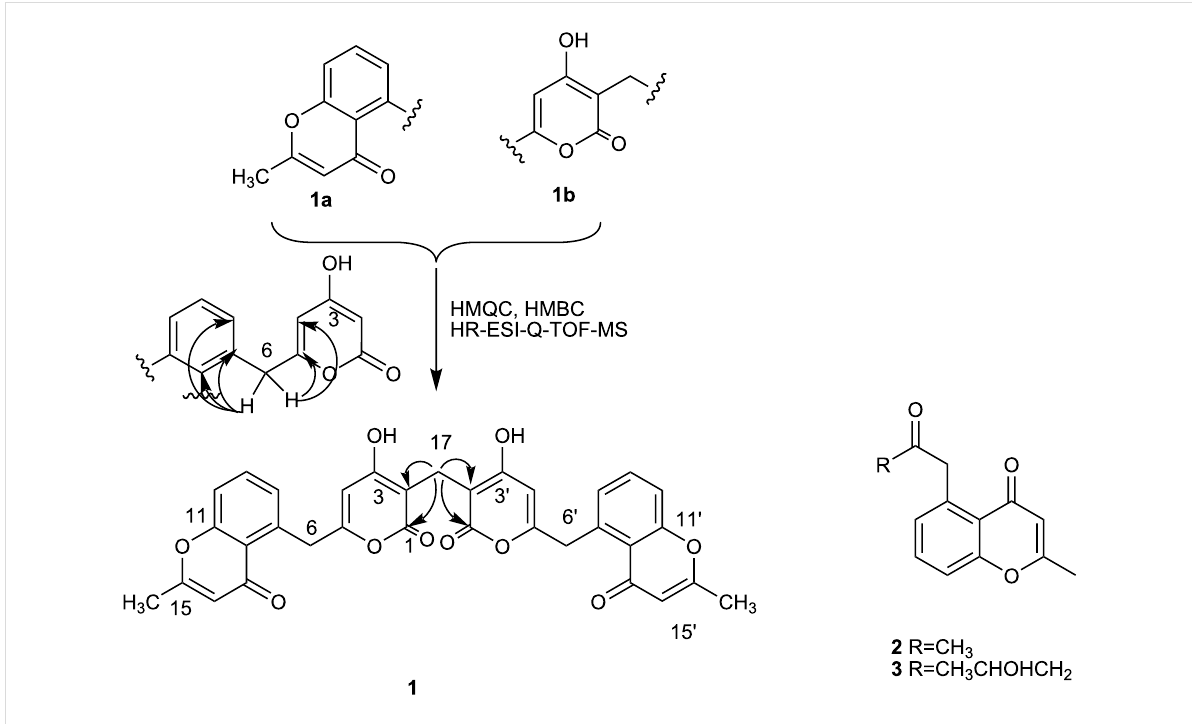
Figure 1: The fragments 1a and 1b of compounds 1 and compound 2 , 3 and the selected HMBC correlations